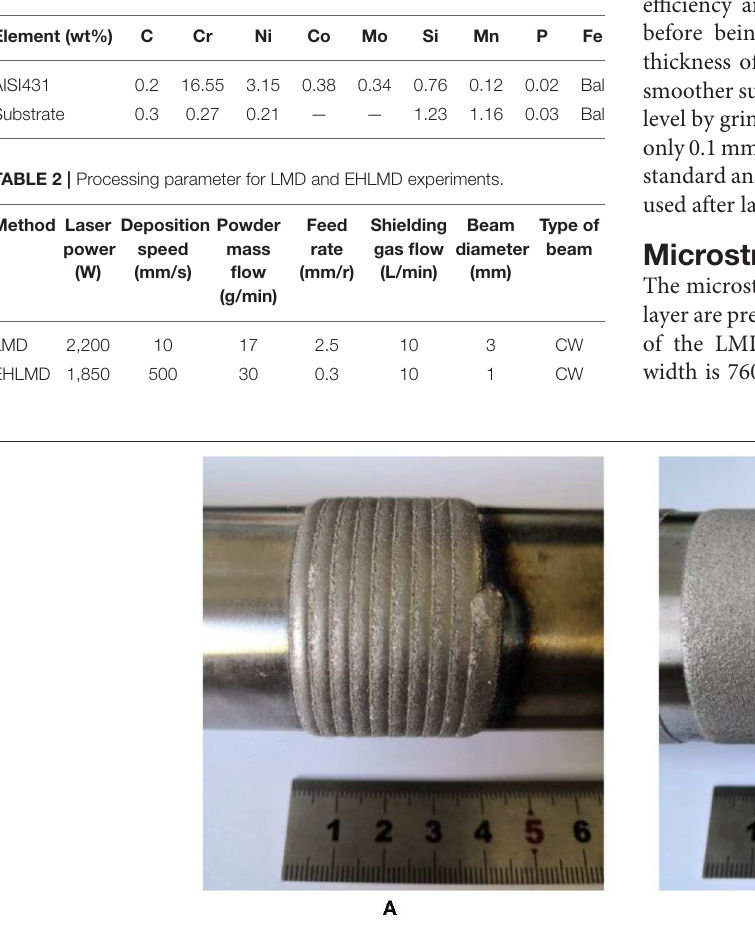
TABLE 1 | Chemical compositions of the AISI431 powder and 27SiMn substrate.